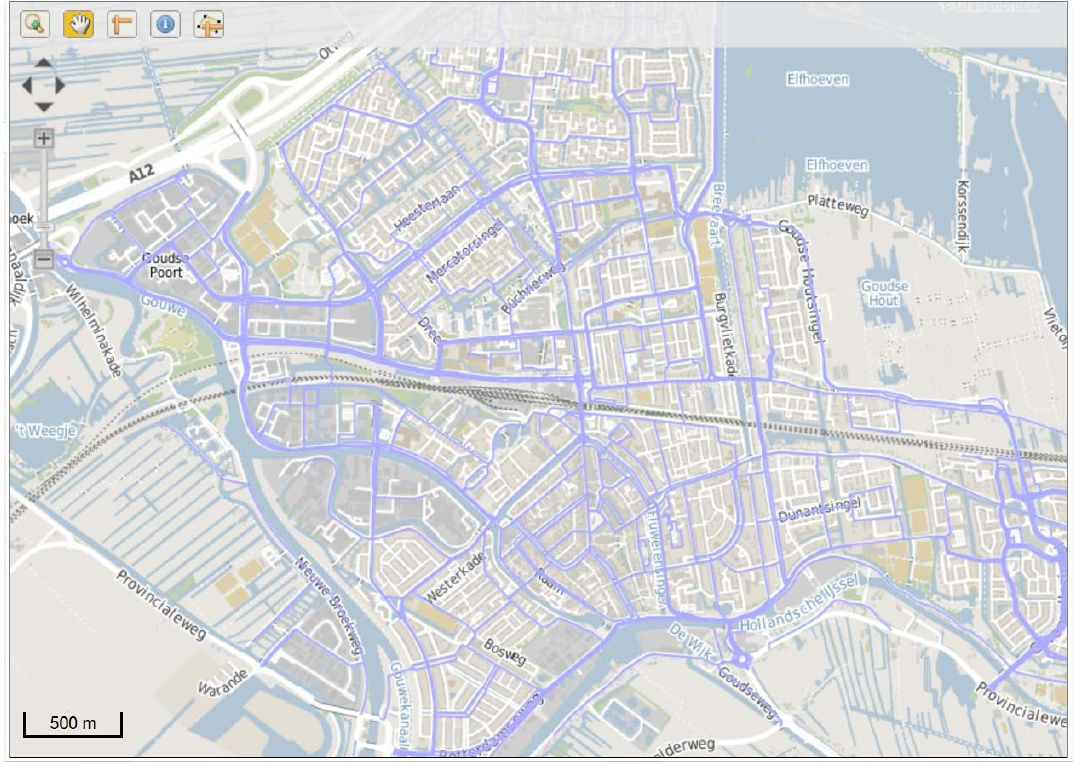
Figure 4. Map of main cycling paths in Gouda (in purple). Narrower streets (in white) are cycle-friendly but shared with other modes. Map courtesy of the City of Gouda. An interactive map of cycling routes in Gouda is also provided by: http://www.routeyou.com/nl-nl/location/bike/47477936/fietsen-in-gouda- overzicht-van-alle-fietsroutes Table 1. Basic data about the case study cities